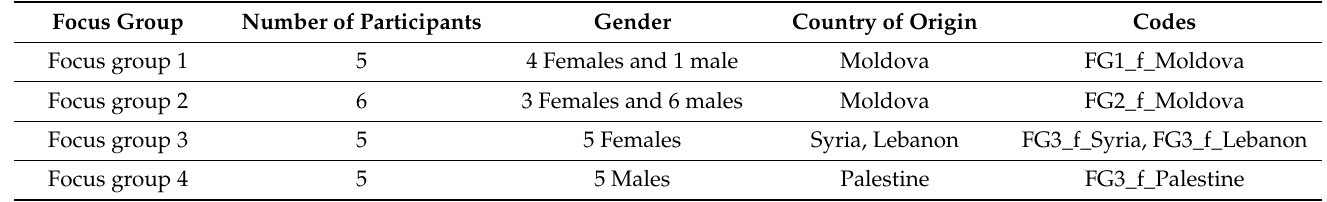
Table A2. Description of the focus group